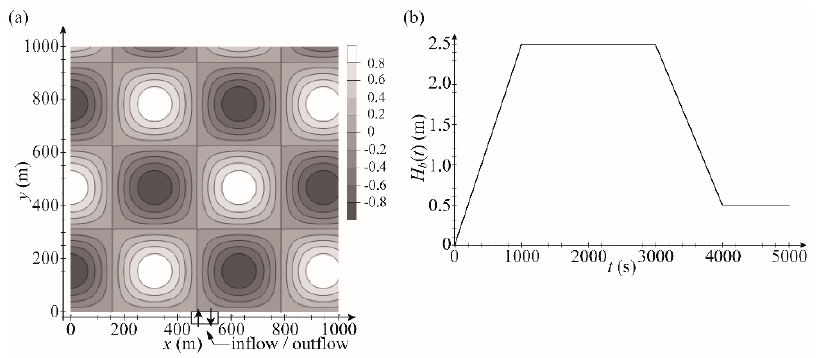
Figure 8. Contour density plot of the bottom elevation ( a ) and the Dirichlet type boundary condition ( b ) assumed in the two-dimensional wave propagation